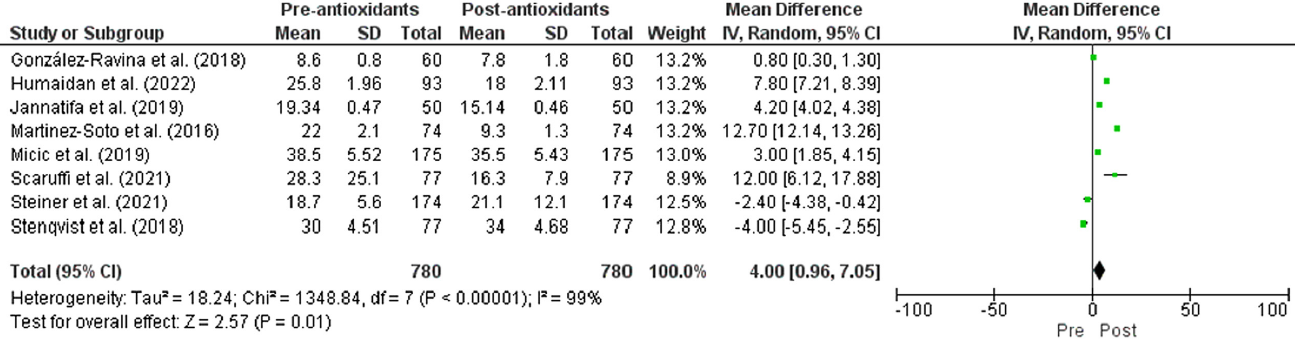
Figure 3. A forest plot of sperm concentration post-antioxidant supplementation.